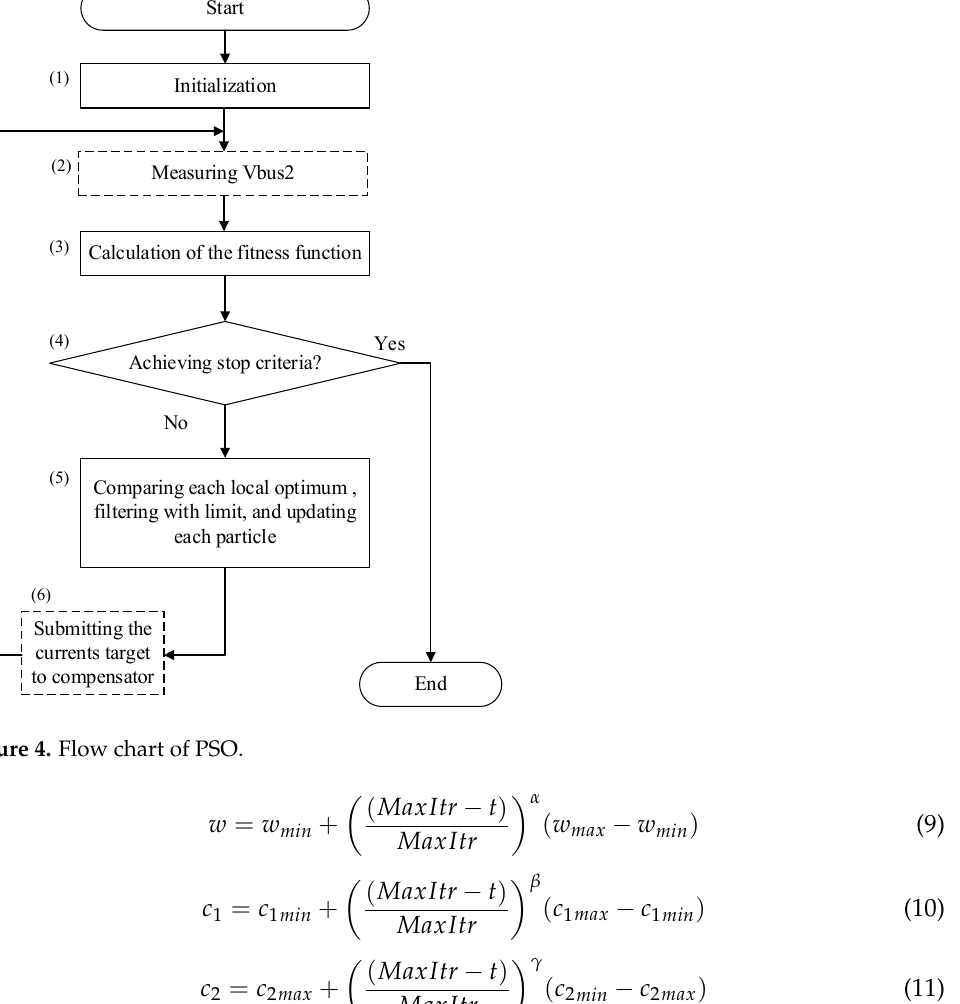
where the inertia coefficient, w , had a default setting of 0.2; w max and w min are the bound- aries of w , with defaults of − 0.8 and 0.2. Learning factors, c 1 and c 2 , had defaults of 2.5 and 0.5. The maximum and minimum, c max and c min , were 2.5 and 0.5; α , β , and γ are the powers of w , c 1 , and c 2 , set at 1.2, 1.5, and 2, respectively.